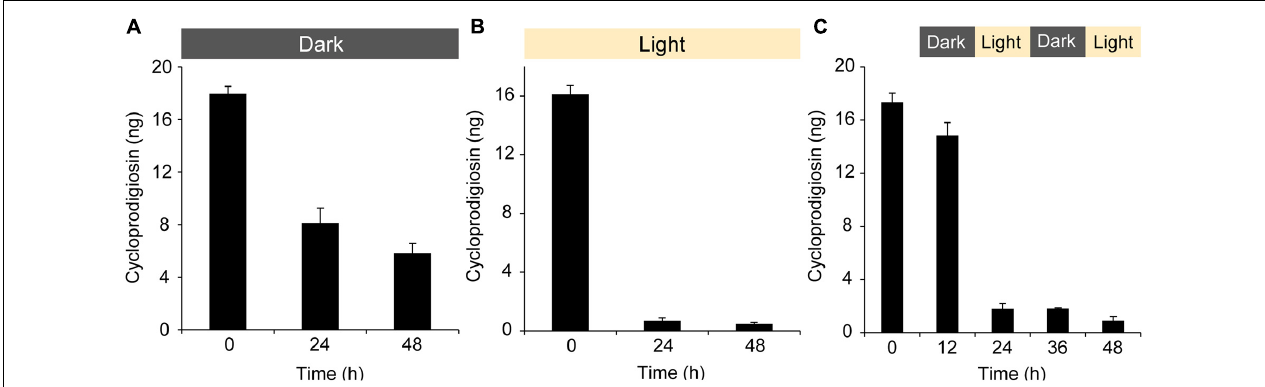
FIGURE 2 | The influence of light and its absence on the isolated pigment cycloprodigiosin (I). 1 µ g of (I) was added to a 5 mL well plate, the solvent MeOH evaporated and 5 mL FASW added on top of the isolated pigment. The concentration changes of (I) over 0, 12, 24, 36, and 48 h at (A) complete darkness, (B) white light and (C) alternating 12 h dark/light cycles were monitored after discarding the water and re-extracting the well plate with 200 µ L MeOH. (5 µ L injected to the UPLC-MS).